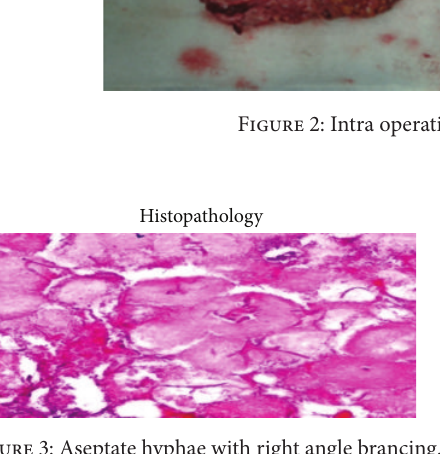
Figure 3: Aseptate hyphae with right angle brancing. Figure 4: PAS